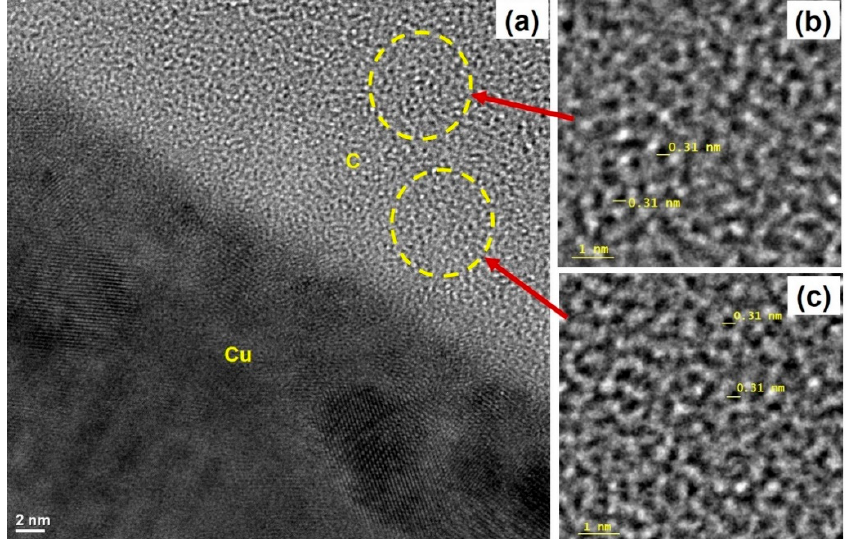
Figure A7. ( a ) High-resolution cross-sectional TEM image of the carbon film on a copper film which was grown on a silicon wafer, showing a homogenous amorphous carbon film without any nanolayered structures on the interface or anywhere else; ( b , c ) enlarged views of the film. Scale bar in ( a ): 2 nm; Scale bar in ( b , c ): 1 nm.